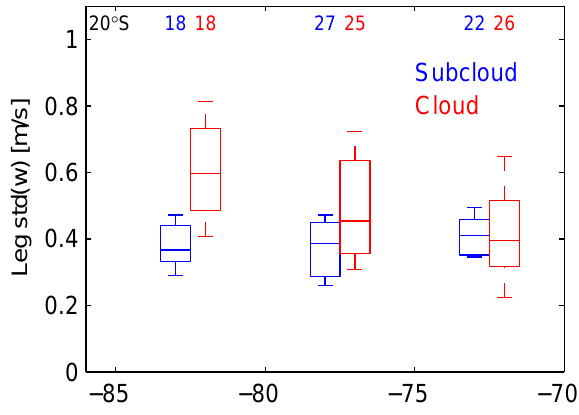
Fig. 18. Boxplots of standard deviation of w from C130 20 ◦ S in- cloud and subcloud